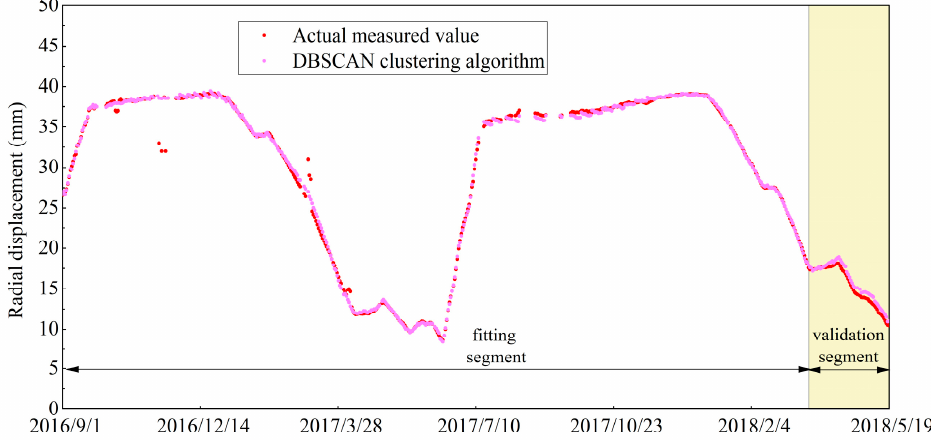
Figure 8. Dam monitoring model after eliminating gross errors by the DBSCAN clustering algo- rithm.